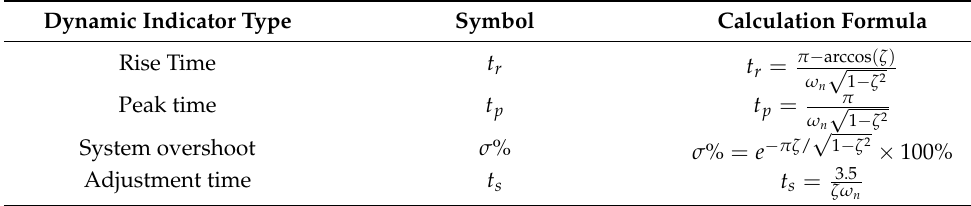
Table 1. Dynamic index of second-order, underdamped system.